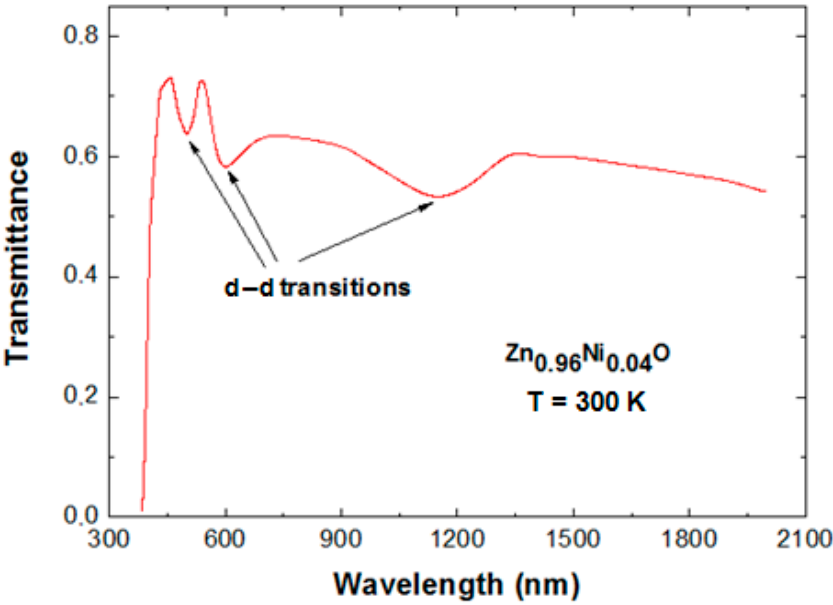
Figure 7. The d–d transitions of Ni 2+ ions in transmittance spectrum of Zn 0.96 Ni 0.04 O thin film.